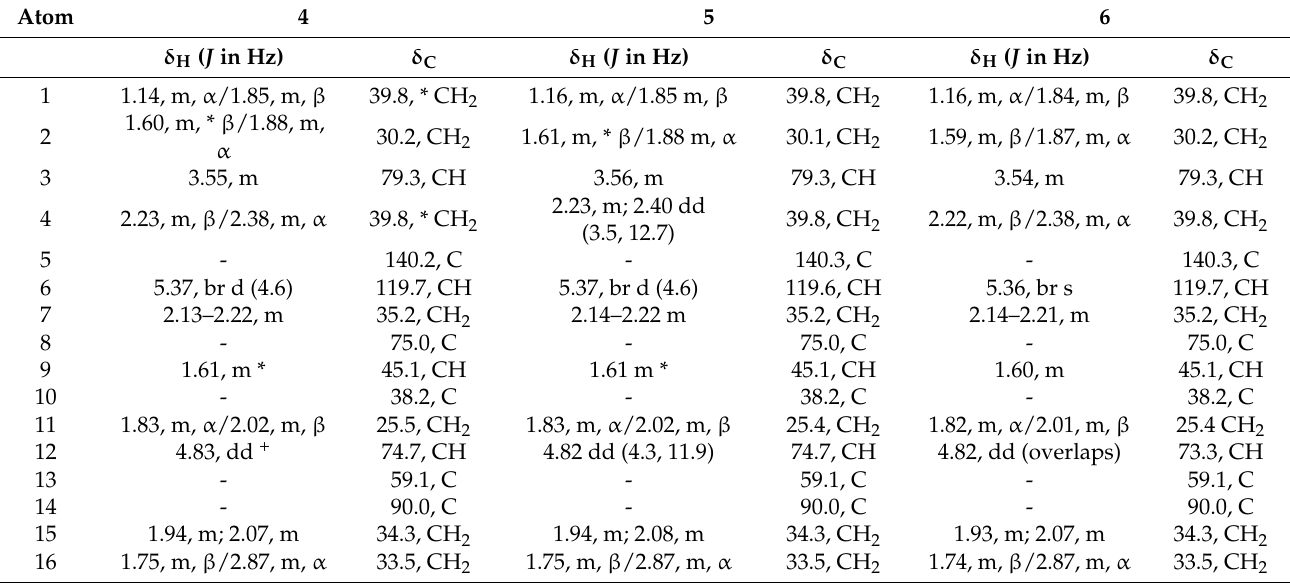
Table 2. The 1 H and 13 C NMR data for compounds 4 – 6 in CD 3